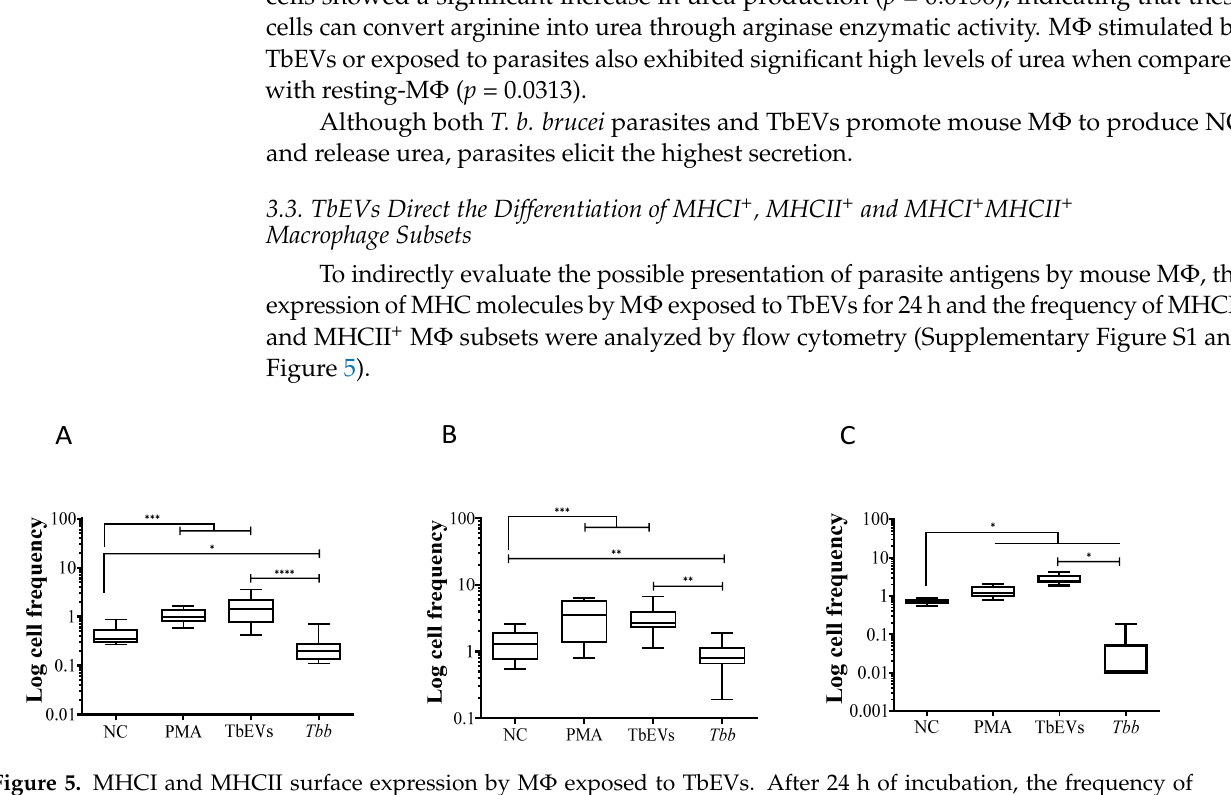
Figure 4. Production of nitric oxide and urea by macrophages exposed to TbEVs. M Φ (arrows) exposed to trypomastigote forms were observed under an inverted light microscope ( A , size bar—20 μ m, ×100 magnification). NO ( B ) and urea ( C ) production were evaluated in M Φ exposed to T. b. brucei ( Tbb ) parasites, in M Φ stimulated by TbEVs and PMA, and in resting-M Φ (negative control, NC). Results of three independent experiments ( n = 12) and two replicates per sample are represented by whiskered box plots, including median, minimum, and maximum values. The non-parametric Wilcoxon matched-pairs signed-rank test was used for statistical comparisons ( p < 0.05). * ( p < 0.05) and ** ( p < 0.01) indicate statistical significance.